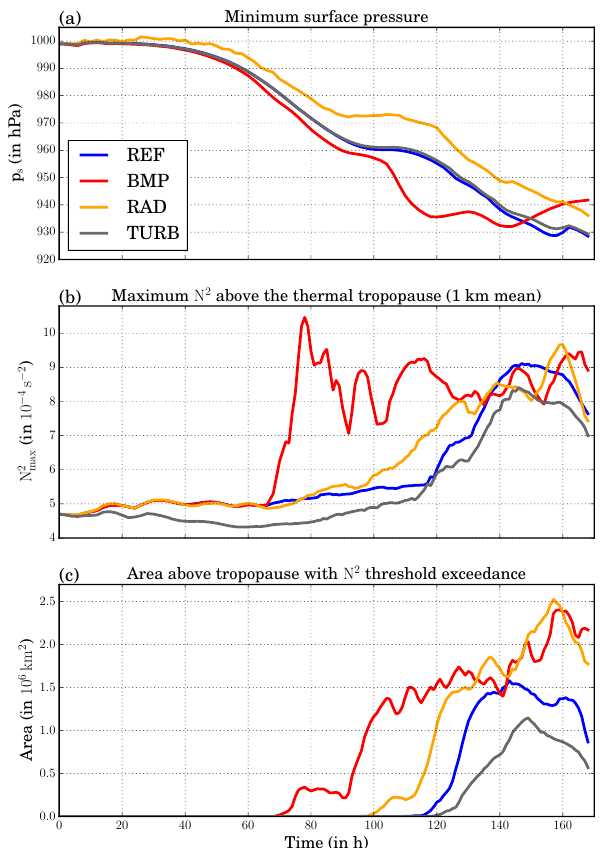
Figure 3. Temporal evolution over the entire simulated life-cycles of (a) the minimum surface pressure p s (in hPa), (b) the maximum static stability N 2 max (in 10 − 4 s − 2 ) above the thermal tropopause, and (c) the area A 5 . 5 (in 10 6 km 2 ) of N 2 threshold exceedance above the thermal tropopause (with a threshold of N 2 = 5 . 5 × 10 − 4 s − 2 ). The colored lines indicate the following simulations: REF (blue), BMP (red), RAD (orange), and TURB